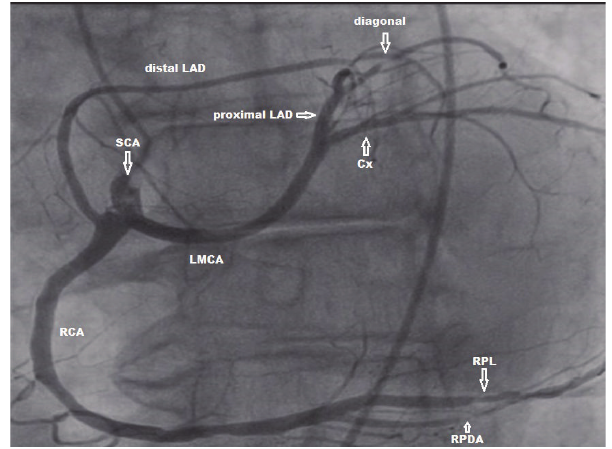
Figure 1: Coronary angiographic image (left anterior oblique 30 ∘ /0 ∘ projection, field of view 25 cm 2 ) showing single coronary artery (SCA) arising from the right sinus of Valsalva as short common trunk which divides into right coronary artery (RCA) and left main coronary artery (LMCA). LMCA further bifurcates into the proximal left anterior descending (LAD) artery and the circumflex (Cx) artery. The distal LAD originates separately from the right coronary artery. Stenotic lesions in right posterolateral (RPL) and right posterior descending (RPD) arteries are also depicted.